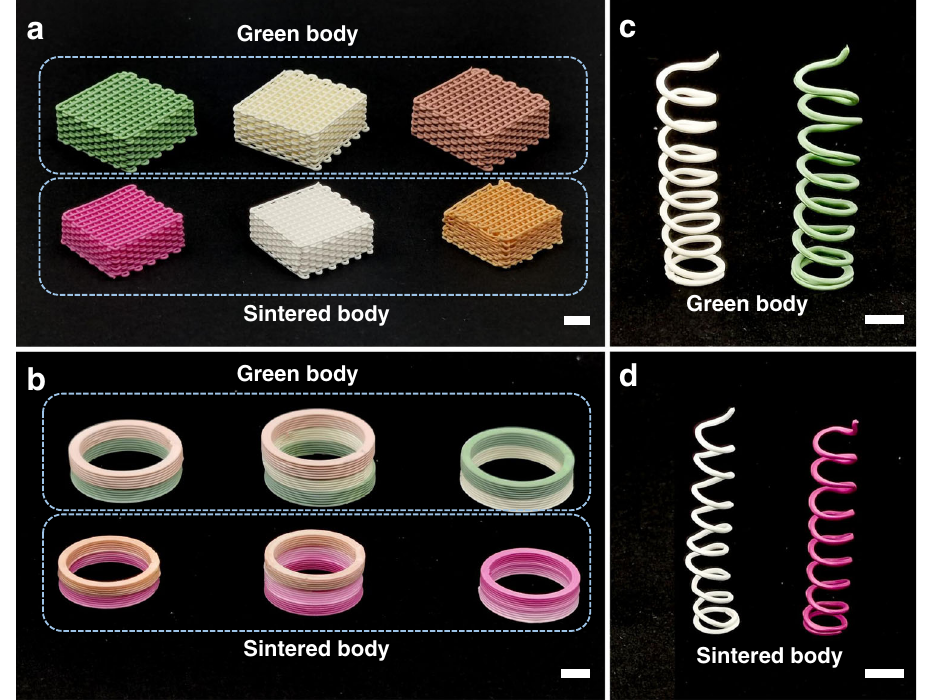
Fig. 5 | Multi-material universal printing of different slurries by NIR-DIW. a Photographsofgridstructure, b discretegradientstructure, c springgreenbody, and d sinteredspringprintedwith0.60mmnozzle.Forcoloredceramicslurry,the